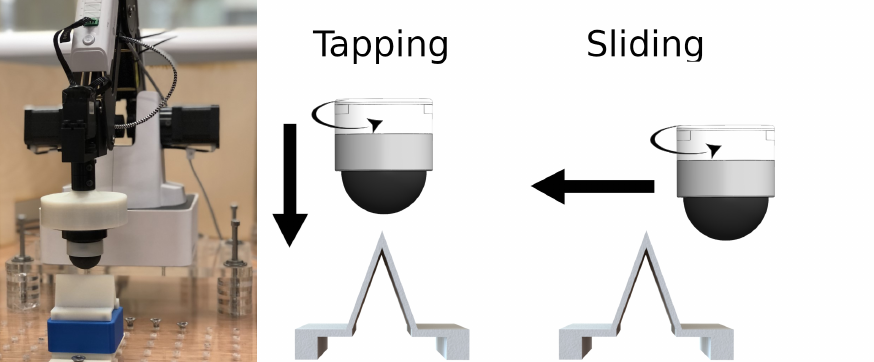
Figure 2. Experimental setup. Left panel . The Dobot Magician robotic arm with the attached NeuroTac sensor above the edge stimulus at the start of a trial. Middle panel . During the tapping experiment, the NeuroTac is brought vertically downward onto the edge stimulus to a depth of 2mm, before returning to its starting position and rotating 10 ◦ . Right panel . During the sliding experiment, the NeuroTac is brought horizontally across the edge stimulus at a constant height of 2mm below the apex of the edge before being returned to its start position and rotated 10 ◦ for the next